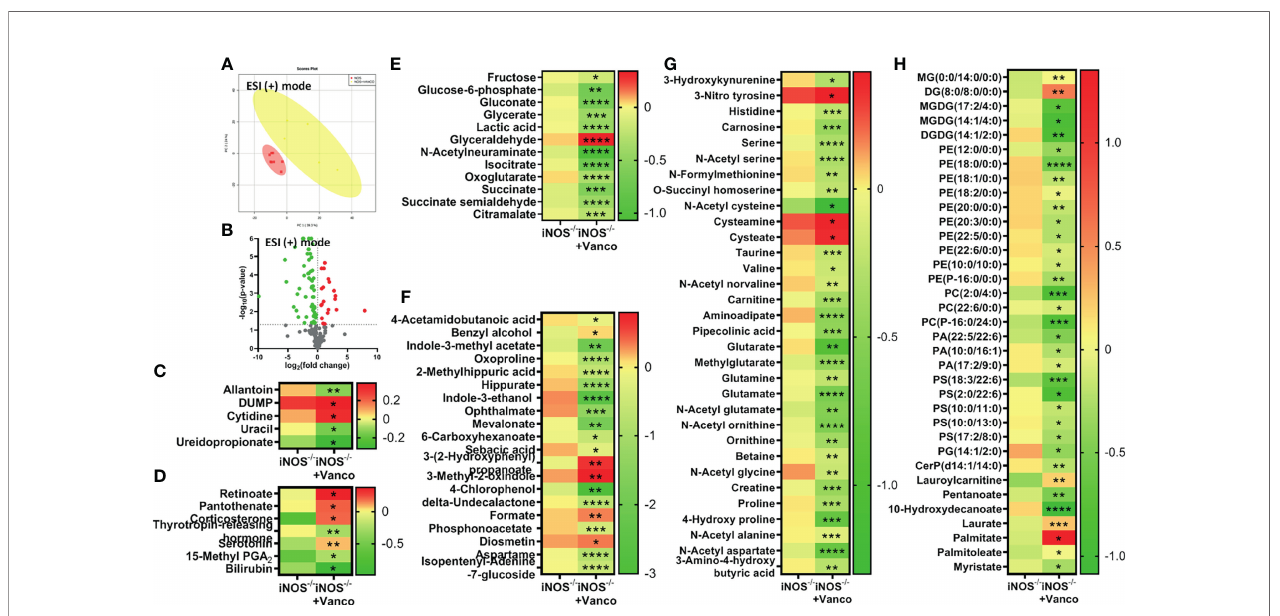
FIGURE 3 | Vancomycin-induced alterations in serum metabolites in iNOS − / − mice. Serum metabolomic analysis in untreated and vancomycin-treated iNOS − / − mice in ESI (+) mode. (A) PCA score plot and (B) volcano plot of differential metabolites between iNOS − / − mice with or without vancomycin treatment. Red in the volcano plot indicates signi fi cantly upregulated metabolites, green indicates the downregulated metabolites, and gray shows no signi fi cant difference. Heatmap of differential metabolites found by metabolomics analysis in iNOS − / − mice with and without vancomycin treatment related to (C) nucleic acid metabolism; (D) vitamins, hormones, and bile acid metabolism; (E) carbohydrate metabolism; (F) miscellaneous/microbiota-derived metabolites; (G) amino acid metabolism; and (H) lipid metabolism. Data are represented as mean ± SEM ( n ≥ 6). * p < 0.05, ** p < 0.01, *** p < 0.001, **** p < 0.0001 vs. iNOS − / − . See also Figures S4, S5